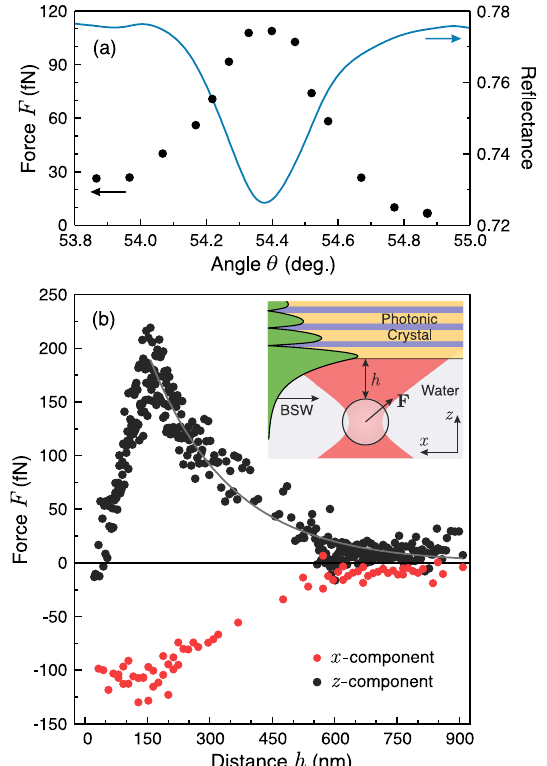
Figure 9. ( a ) Experimental angular dependences of the photonic crystal (PC) reflectance (solid curve) and the magnitude of the BSW-generated force acting on a trapped microparticle at a PC/particle gap of approximately 300 nm (dots). Angle θ is the angle of incidence in the prism. The peak value corresponds to the BSW resonance angle; ( b ) x - (red dots) and z -coordinate (black dots) projection values of the BSW-generated force as a function of the distance between the trapped microparticle and the PC surface. Reprinted with permission from D.A. Shilkin, E.V. Lyubin, I.V. Soboleva, A.A. Fedyanin, Opt. Lett. 40, 4883 (2015). c (cid:13) 2015 Optical Society of America